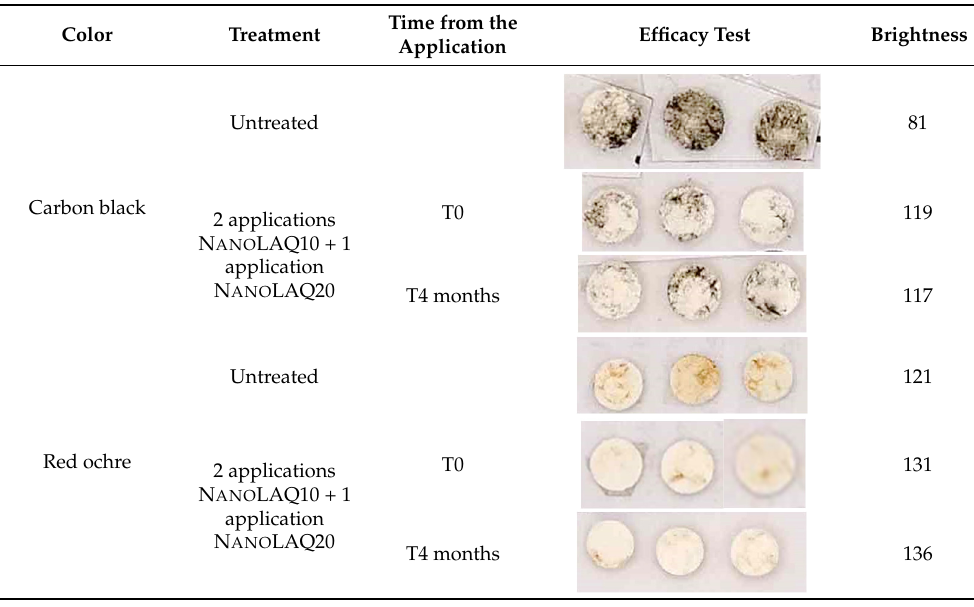
Table 7. DeltaE values of treated and untreated areas of paintings in situ. Color of the Paint Layer